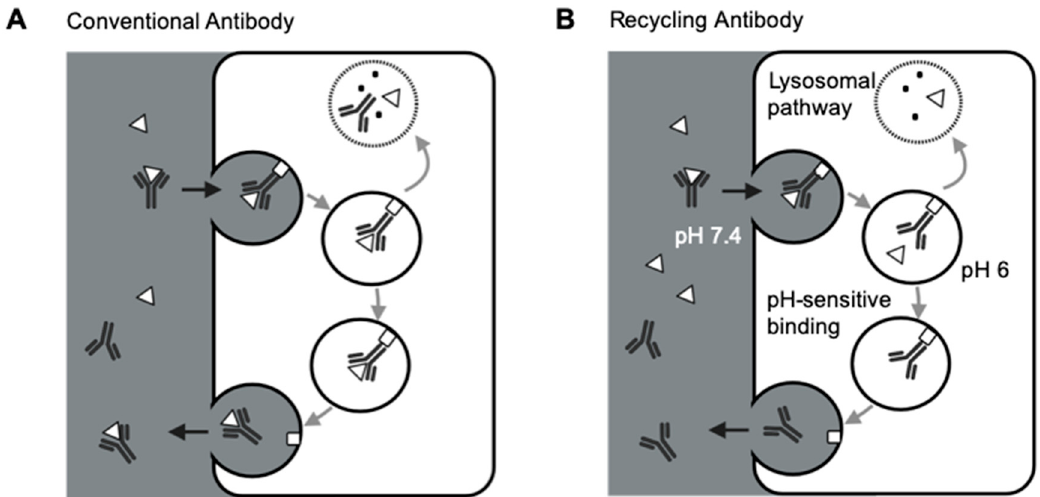
Figure 2. Schematic of FcRn-mediated recycling for conventional antibodies and recycling antibodies. ( A ) FcRn-mediated recycling for conventional antibodies. Conventional antibodies and the target-antibody complex are both salvaged and recycled back to the circulation by FcRn, making each antibody only has one chance of binding to the targeted antigen. ( B ) FcRn-mediated recycling for recycling antibodies. Recycling antibodies can disassociate the target antigens in the acidic endosomes due to the pH-sensitive antibody-target binding. FcRn recycles the antibodies, not the targets, making each antibody has more than one chance of binding to the targeted antigens. Δ : antigen; □ : FcRn.